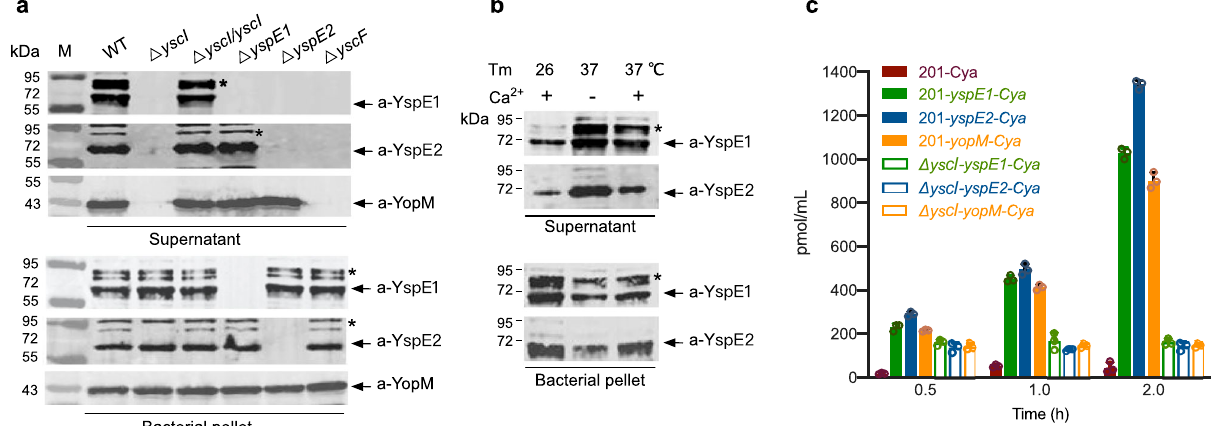
Fig.1|SecretionofNELsof Y.pestis IsT3SSDependent.a Bacterialstrainsofthe wild type Y. pestis and various mutants were grown in TMH medium without cal- cium at 37°C and proteins in culture supernatants and bacterial pellets were analyzed by immunoblotting with speci fi c antibodies against YspE1, YspE2 or YopM. The bands labeled with “ * ” might come from some unknown complexes involved in YspE1/YspE2. b Y. pestis strain 201 were grown in TMH at 26°C, or in TMHwithorwithoutcalciumat37°Casindicated.Proteinsinculturesupernatants and bacterial pellets were analyzed as described in a . The image of a and